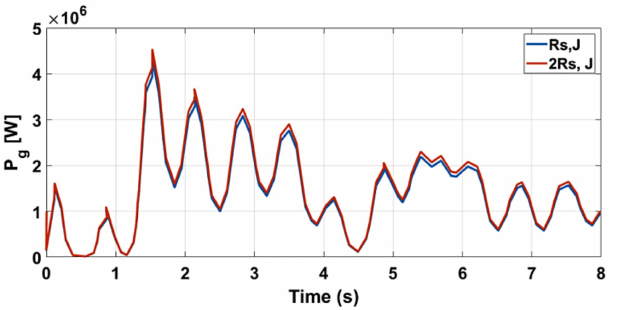
Figure 19. Active